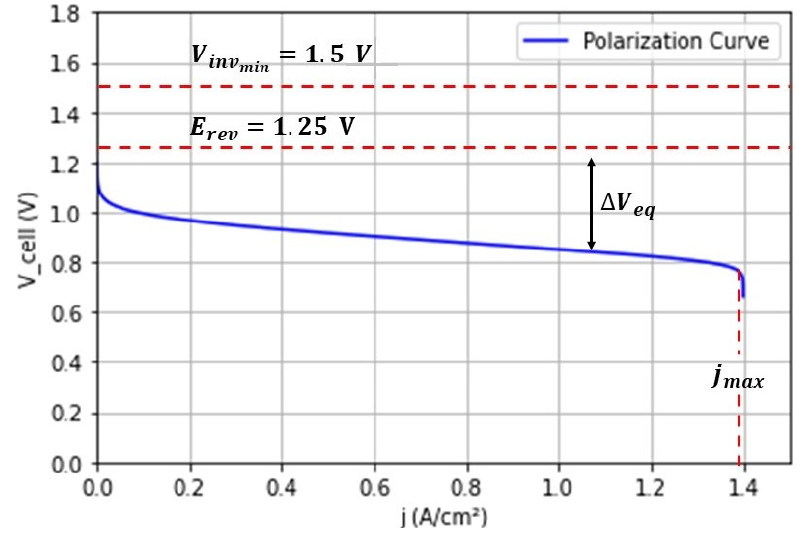
, E rev , and j max . min